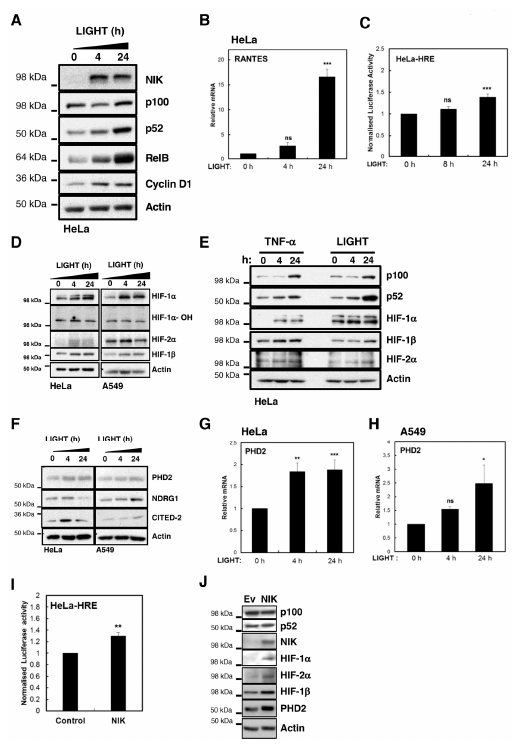
Figure 1. LIGHT, a non-canonical NF- κ B inducer, induces HIF expression and activity. ( A ) HeLa cells were treated with 100 ng/mL LIGHT for 0, 4 and 24 h. Whole cell lysates were prepared and analysed by western blot for the indicated non-canonical NF- κ B pathway regulators, subunits and target genes. β -Actin was used as loading control. ( B ) HeLa cells were treated with 100 ng/mL LIGHT for 0, 4 and 24 h prior mRNA extraction and RT-qPCR analysis for RANTES transcript, normalised to Actin mRNA levels. All the values were normalised to the untreated sample. The graphs depict mean and SEM determined from at least three independent experiments. One-way Anova analysis was performed and significance determined as follows: ns = not significant, *** p ≤ 0.001. ( C ) HeLa cells, stably transfected with HRE luciferase reporter, were treated with 100 ng/mL LIGHT for 8 and 24 h prior to luciferase measurements. All of the values were normalised to the untreated sample. Graph depicts mean and SEM of a minimum of three independent biological experiments. One way Anova analysis was performed and significance determined as follows: ns = not significant, *** p ≤ 0.001. ( D ) HeLa and A549 cells were treated with 100 ng/mL LIGHT for 0, 4 and 24 h prior collection of whole cell lysates and western blot analysis for the depicted proteins. β -Actin was used as loading control. ( E ) HeLa cells were treated with 10 ng/mL TNF- α and 100 ng/mL LIGHT for 0, 4 and 24 h. Then, whole cell lysates were collected and western blot analysis was performed for the depicted proteins. β -Actin was used as loading control. ( F ) HeLa and A549 cells were treated with 100 ng/mL LIGHT for 0, 4 and 24 h. Then, whole cell lysates were collected and western blot analysis was performed for a subset of HIF- α specific targets. β -Actin was used as loading control. ( G ) HeLa cells and ( H ) A549 cells were treated with 100 ng/mL LIGHT for 0, 4 and 24 h, prior mRNA extraction and RT-qPCR analysis for PHD2 gene transcript, normalised to Actin mRNA levels. All the values were normalised to the untreated samples. The graph depicts mean and SEM determined from at least three independent biological experiments. One-way Anova analysis was performed and significance determined as follows: ns = not significant, * p ≤ 0.05, ** p ≤ 0.01, *** p ≤ 0.001. ( I ) Analysis of canonical NF- κ B signalling following NIK expression vectors for 48 h prior to luciferase measurements. All the values were normalised to the control sample. Graph depicts mean and SEM of a minimum of three independent biological experiments. Student t -test analysis was performed and significance determined as follows: ns = not significant, ** p ≤ 0.01. ( J ) HeLa cells were transfected with control and NIK expression vectors for 48 h prior to cell lysis. Western blot analysis was performed using the indicating antibodies. β -Actin was used as loading